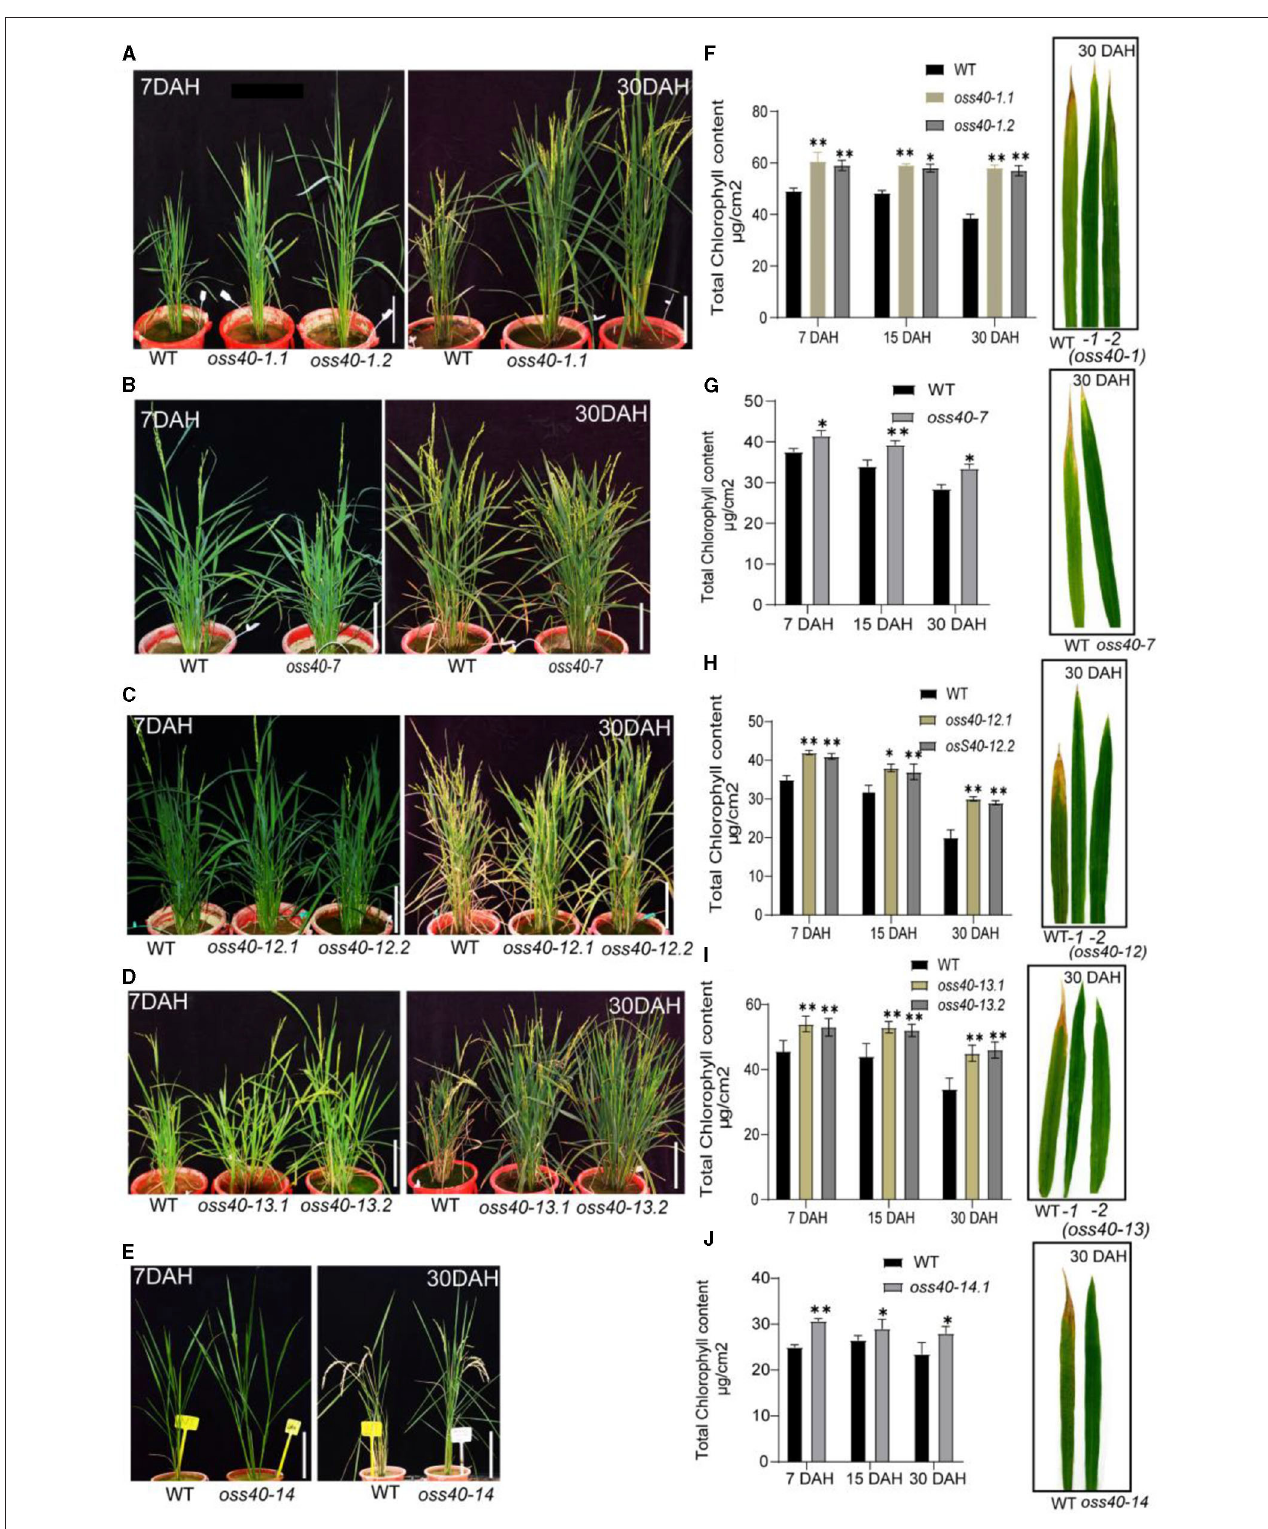
FIGURE 4 | The stay-green phenotype of different oss40 mutant lines during natural senescence. (A,C,E,G,I) represents the phenotype of WT and oss40 ( − 1, − 7, − 12, − 13, and − 14) mutants, respectively, at 7 DAH and 30 DAH (days after heading). (B,D,F,H,J) show total chlorophyll levels of WT and oss40 mutants at 7DAH, 15DAH, and 30DAH, respectively. Five flag leaves were used for chlorophyll content measurement. Mean and SD values were obtained from three biological replicates. Significant differences of the chlorophyll levels normalized to WT were evaluated using a paired Student’s t -test (* p < 0.05; ** p < 0.01).